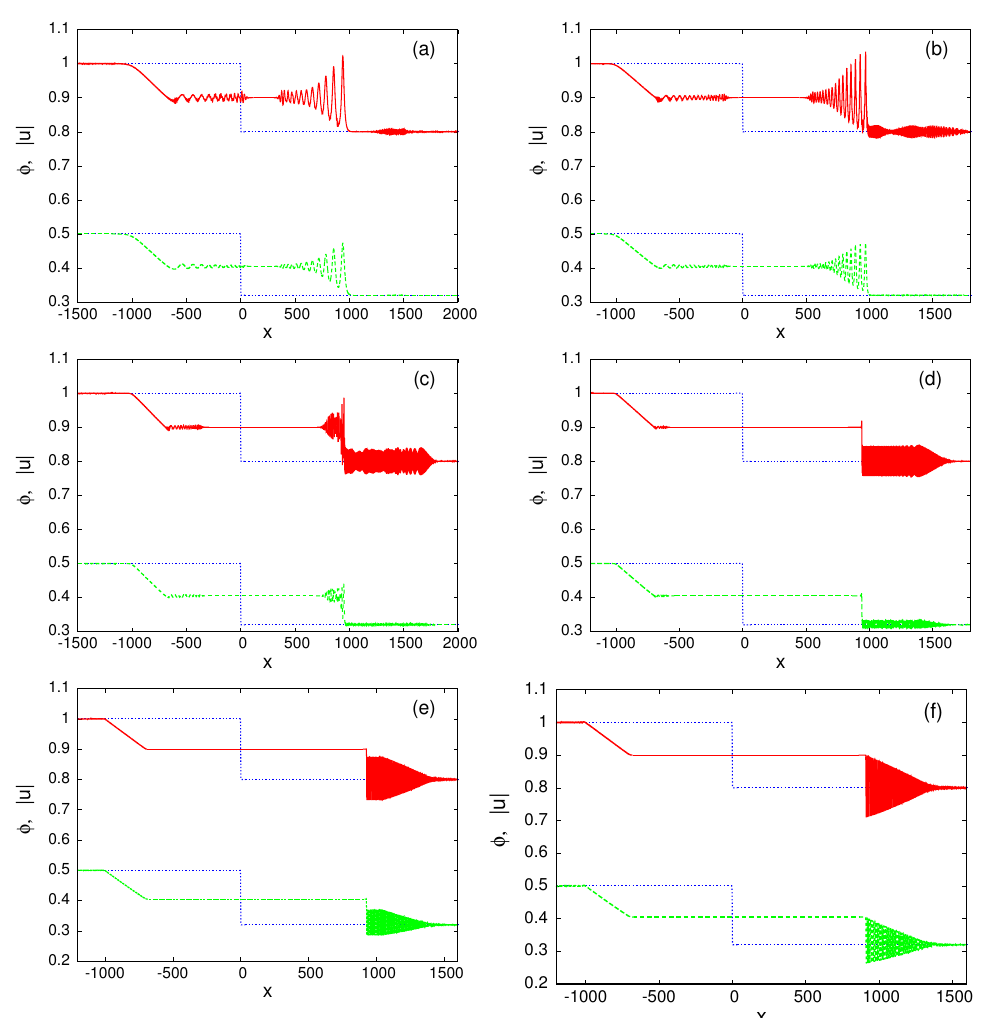
Figure 2. Numerical solutions of nematic Equations (11) and (12) for initial condition (13) with u + = 0.8 and u − = 1.0. Red (solid) lines: | u | at z = 1000; green (dashed) lines: φ at z = 1000; blue (dotted) lines: | u | at z = 0 (upper) and φ at z = 0 (lower). ( a ) PDSW with ν = 200, ( b ) RDSW with ν = 40, ( c ) CDSW with ν = 10, ( d ) TDSW with ν = 3.0, ( e ) resonant NLS type DSW with ν = 1.0, ( f ) NLS type DSW with ν = 0.5. Here, q =